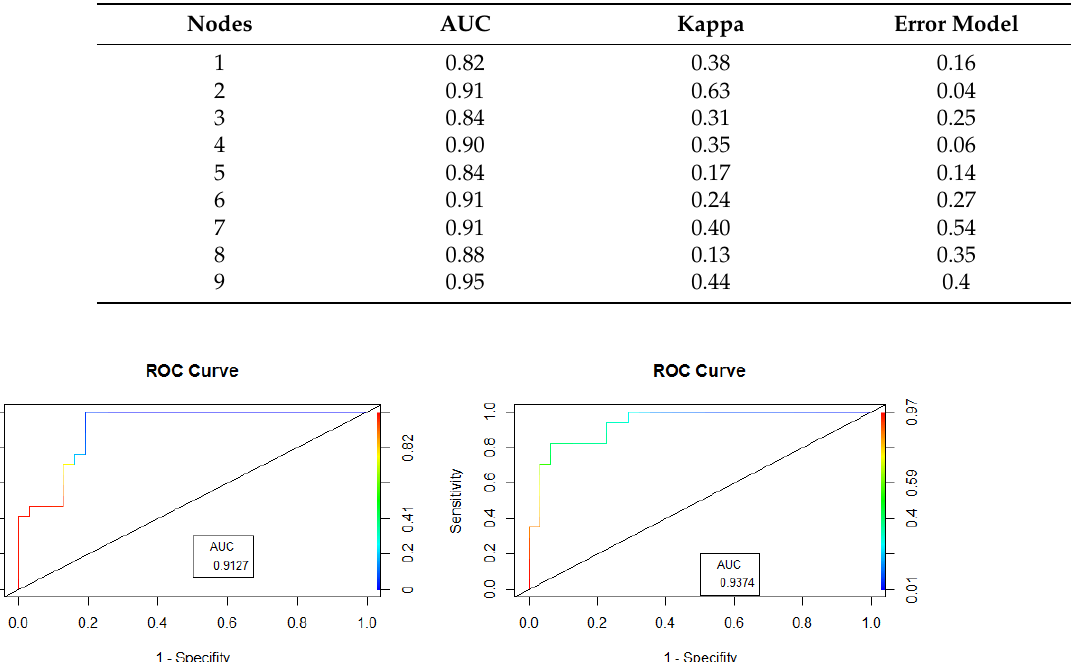
Table 1. AUC, kappa, and error model of ANNs.